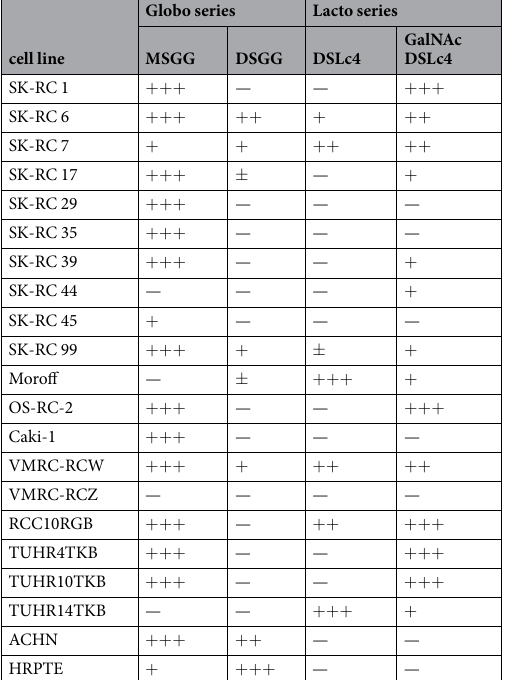
— — Table 1. Expression pattern of renal cancer-related glycolipids. Cell surface expression of globo- and lacto- series glycolipids in 20 renal cancer cell lines and HRPTE (human renal proximal tubule epithelial cells) were analyzed by flow cytometry using anti-glycolipid mAbs as described in “Materials and Methods”. The glycolipid expression levels were classified into 5 groups based on the percentages of positive cells. +++ , 70–100%; ++